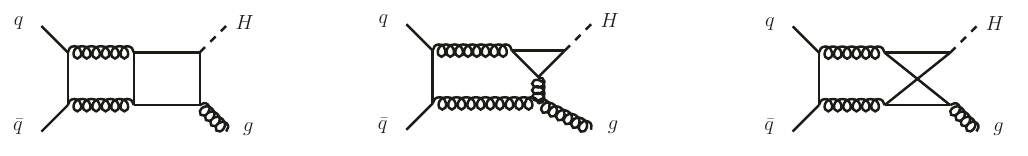
Figure 3 . Examples of two-loop Feynman diagrams that contribute to the process q (cid:22) q ! Hg . The form factors F q;g